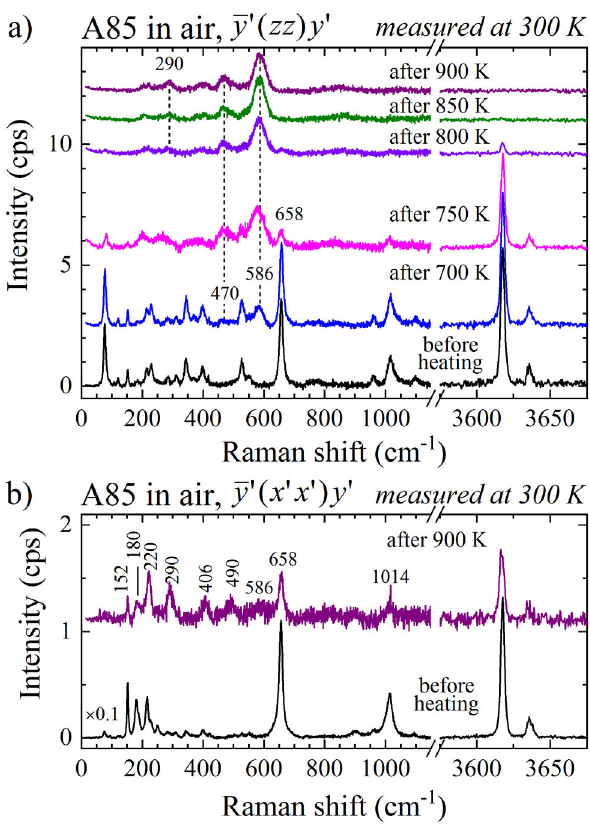
Fig. 4 Polarized Raman spectra of grunerite A85 measured at 300 K after annealing in air to the temperature indicated and subsequently cooled down. a Data collected in (cid:1) y 0 ð zz Þ y 0 scattering geometry; b data collected in (cid:1) y 0 ð x 0 x 0 Þ y 0 scattering geometry. Spectra are vertically offset for clarity. The dashed lines in the upper plot trace the corresponding new Raman scattering signals ~273, 470, and 576 cm − 1 appearing at 700 K in (cid:1) y 0 ð zz Þ y 0 spectra; the negligible room-temperature intensity of the Raman scattering ~815 cm − 1 observed at elevated temperatures indicates that this signal originates from multi-phonon excitation.